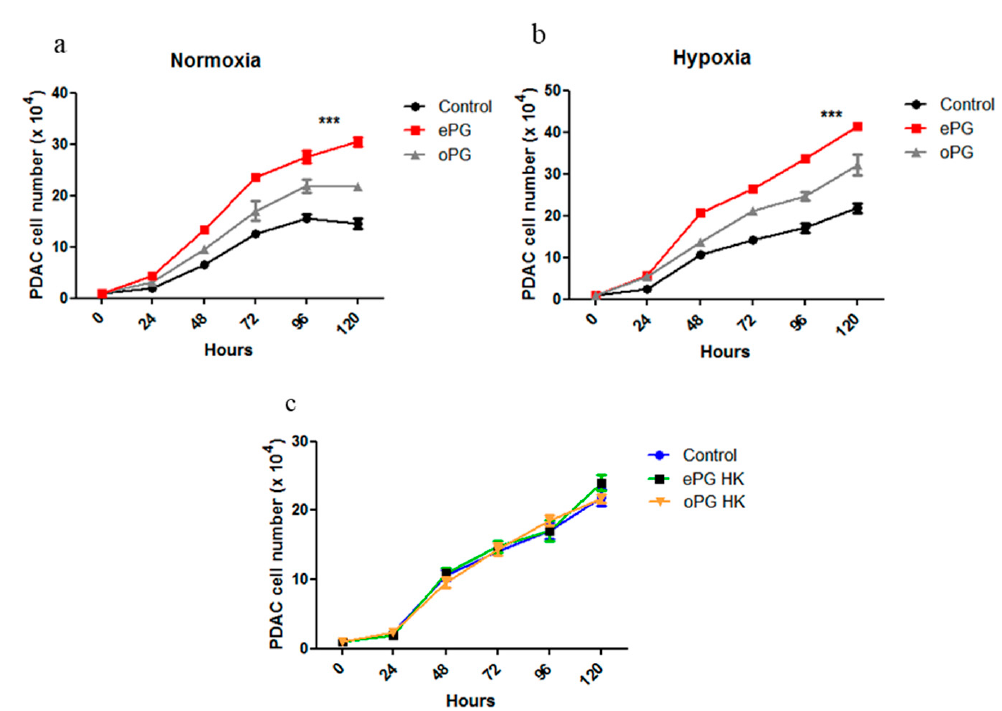
Figure 4. Enhanced P. gingivalis intracellular survival correlates with increased PDAC proliferation. ( a ) PANC1 cells were cultured in normoxia or ( b ) hypoxia alone or in the presence of oPG vs. ePG (MOI 10). For each of the conditions (normoxia vs. hypoxia), the ePG generated in those conditions was used. Extracellular bacteria were killed with antibiotics after one hour of infection, and cell number was calculated at the indicated time points. ( c ) Cells were cultured in hypoxic conditions alone (control) or in the presence of heat-killed (HK) ePG or oPG, and cell number was determined at the indicated time points. Experiment was performed three times. Data show the mean ± SD of a representative experiment ( n = 3). Two-way ANOVA was performed for statistical analysis. *** p ≤ 0.005. The enhanced proliferation induced by ePG was confirmed in three PDAC cell lines at four and six days after infection using an additional test of cell viability (Figure 5a–c). In agreement with increased proliferation, we also found that P. gingivalis -infected cells had elevated levels of cyclin D1, an important regulator of proliferation / cell cycle progression in a variety of tumor types, including PDAC (Figure S2 (Supplementary Materials)) [28]. In addition, we noted that P. gingivalis infection resulted in increased levels of heparanase, an enzyme involved in PDAC tumor growth and aggressiveness (Figure S2 (Supplementary Materials))